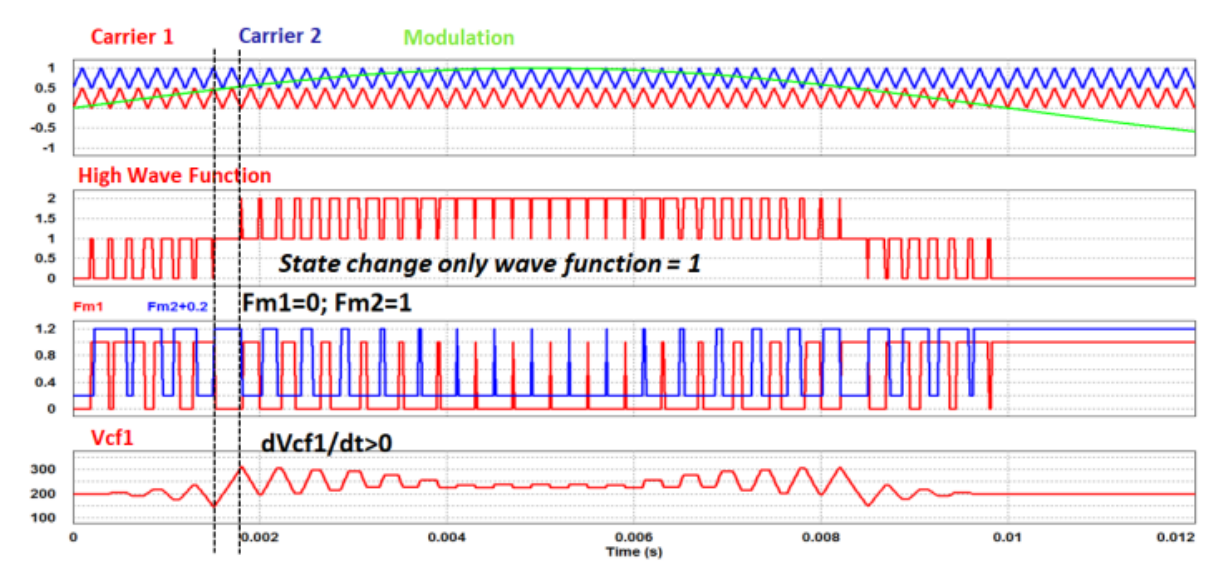
Figure 4. Fundamental control strategy PD for a five − level VIENNA converter. Table 4. Description of the state machine operation for the healthy operation of a five-level VIENNA rectifier for the positive current case.